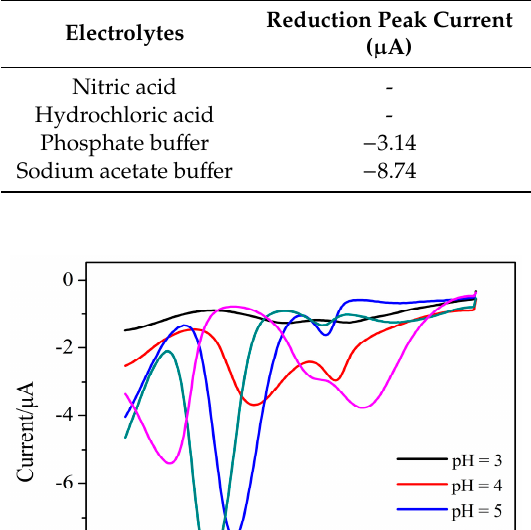
Table 1. The effect of different electrolytes on the reduction current of Cr (VI). Electrolytes.